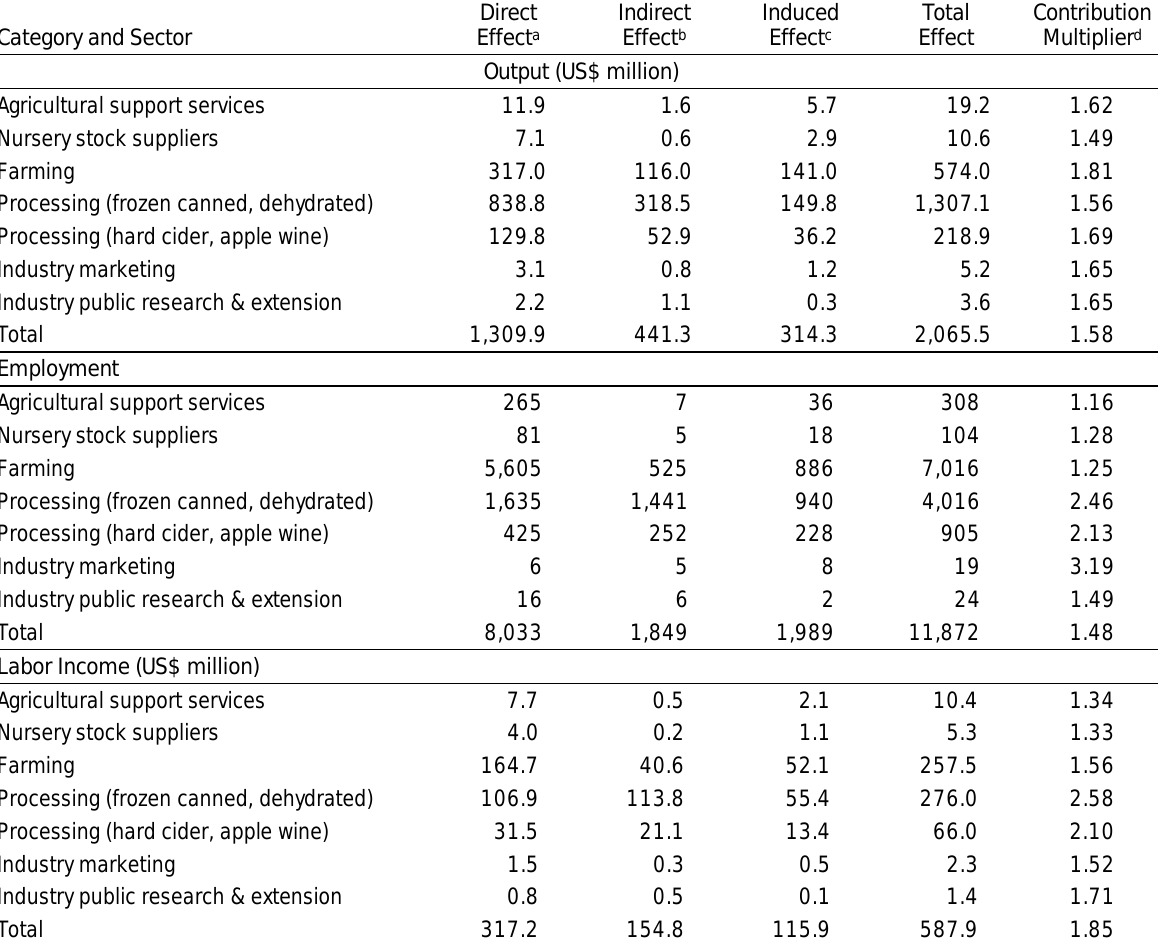
Table 4. Economic Contribution of the Apple Industry in New York, by Sector, 2016 Category and